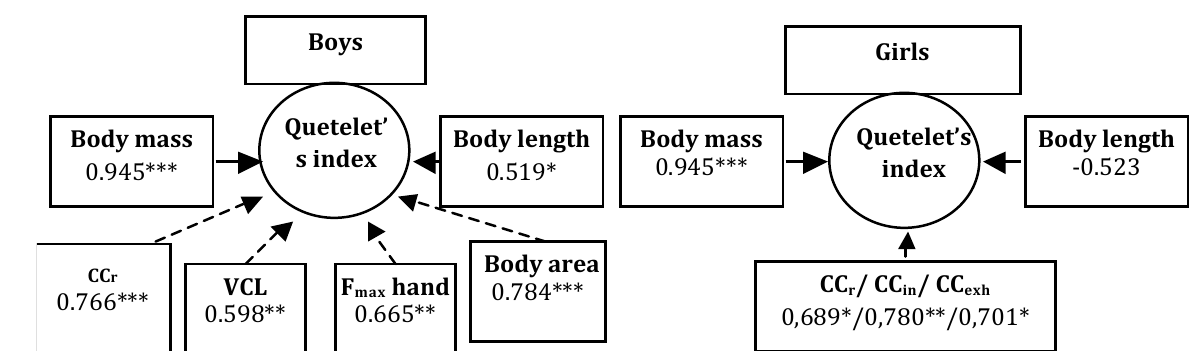
- chest circumference at inhale; CC in